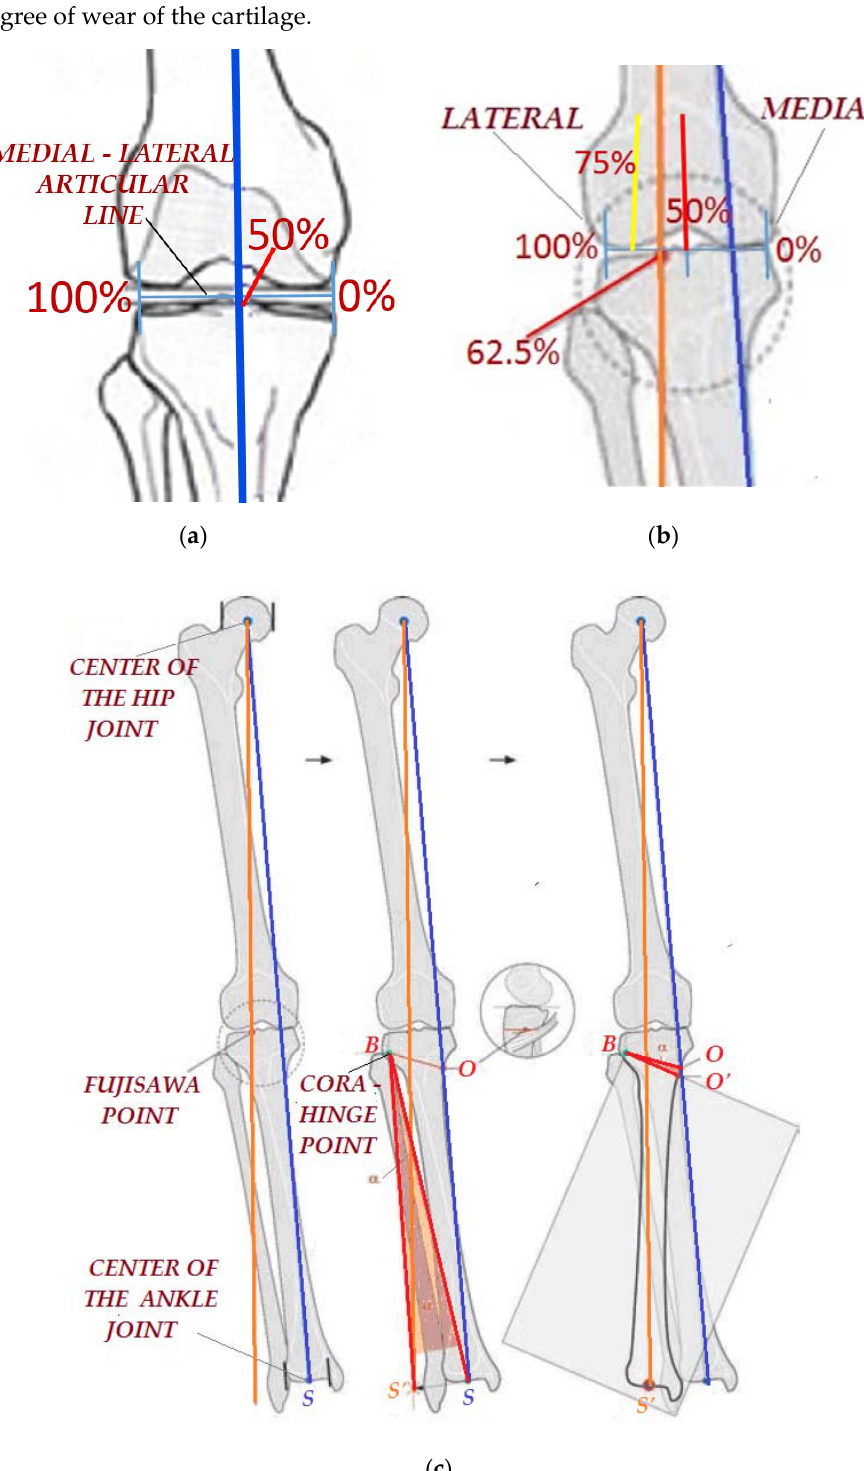
Figure 1. Intersection between the medial-lateral articular line and the mechanical axis of the leg for a healthy knee ( a ); an ostheoartritic knee ( b ); and geometrical planning for the correction using the Miniacci method ( c ).